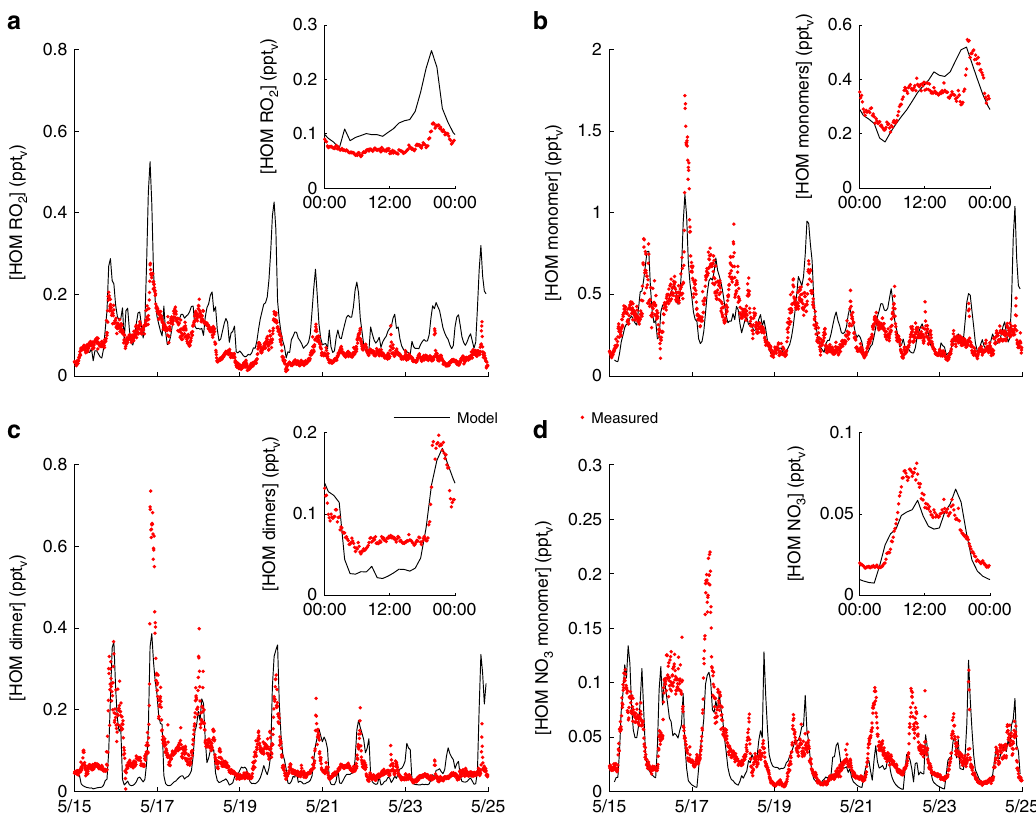
Fig. 3 Highly oxygenated organic molecules (HOM) in the boreal forest. Modelled and measured HOM gas-phase concentrations at the Station for Measuring Ecosystem-Atmosphere Relations II (SMEAR II) between 15 and 24 May 2013. Panel a shows the concentrations of HOM peroxy radicals (RO 2 ), b HOM closed shell monomers without nitrate functional groups, c HOM dimers and d closed shell HOM organonitrate monomers (HOM-NO 3 ). The inset plots in each panel shows the mean diurnal concentration trends of each HOM species type